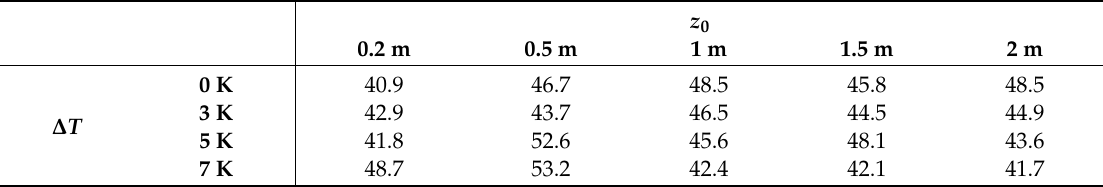
Table 3. Domain maximum vertical velocity (m s − 1 ) in each simulation over the period of t = 140 min to t = 200 min. This time period is centered on when the storms pass over the idealized